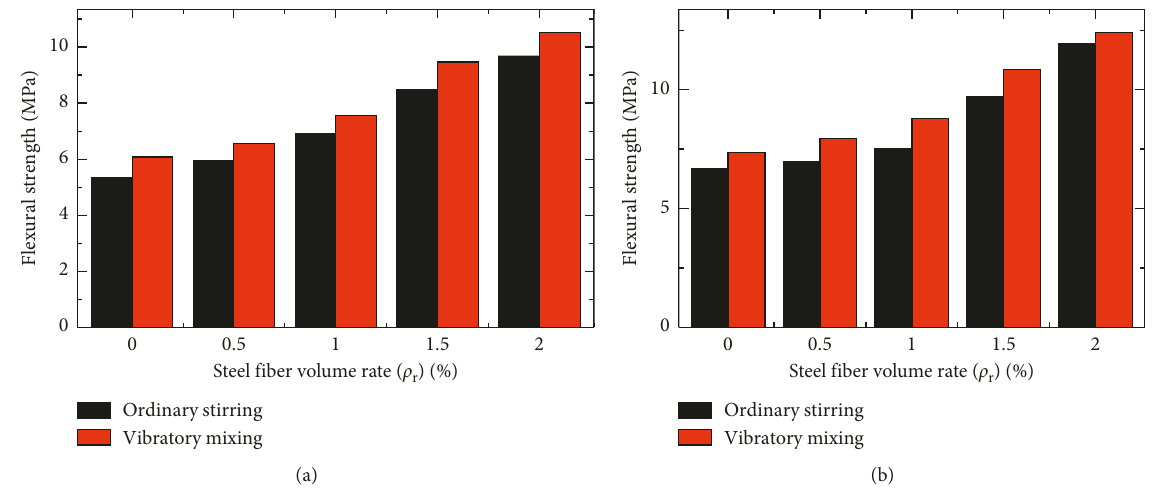
Figure 16: Effect of different mixing methods on the flexural strength of concrete. (a) CF50; (b) CF60.